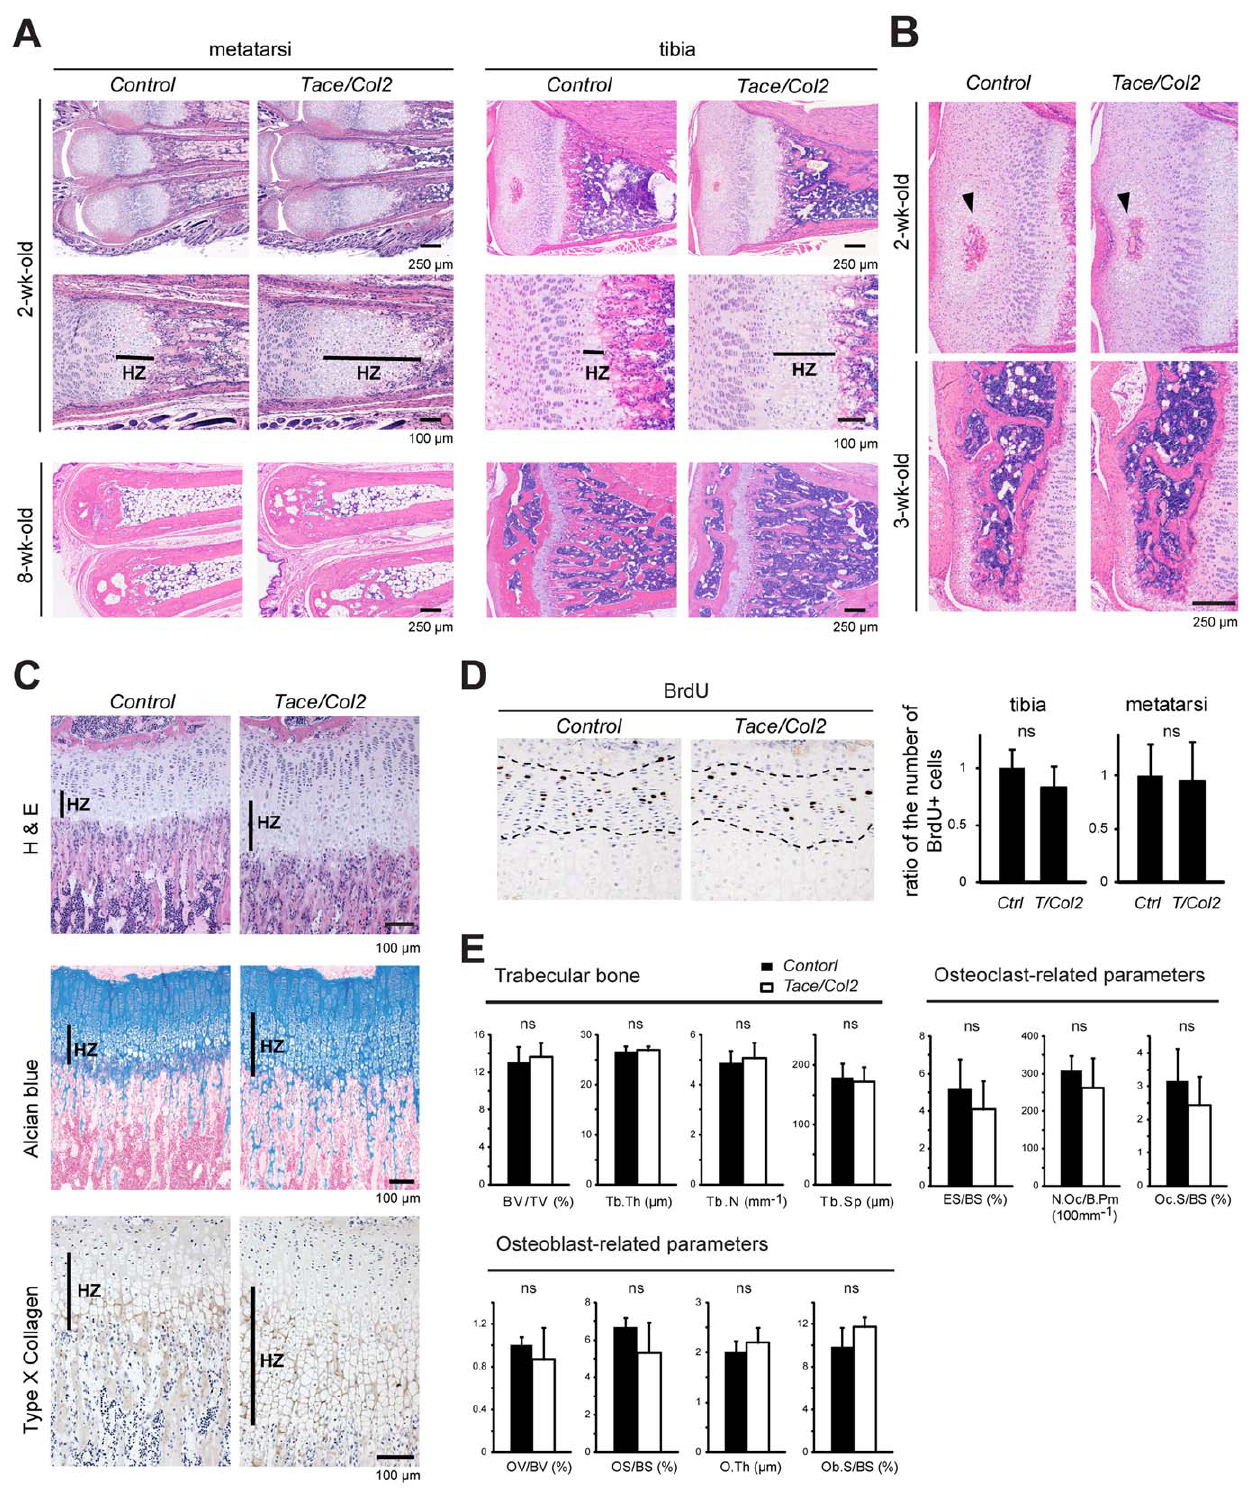
Figure 2. Histological and histomorphometric analysis of the long bones of Control and Tace/Col2 mice. (A) Histological analysis of the metatarsi and tibia (2-week-old, upper panels, and 8-week-old, lower panels, respectively) from Tace/Col2 and Control mice. HZ, hypertrophic zone. (B) Histological analysis of the secondary ossification center of the tibia (2-week-old, upper panels, and 3-week-old, lower panels, respectively) from Tace/ Col2 and Control mice. Arrowheads indicate the secondary ossification center. (C) Sections of tibiae from 3-week-old Tace/Col2 and Control mice stained with alcian blue (upper panels) or immunostained with anti-type X collagen antibody. (D) Immunolocalization of BrdU-incorporated chondrocytes in the proliferating zone (outlined by broken lines) of the tibia harvested from Control and Tace/Col2 mice (left panels). The ratio of the number of BrdU-positive chondrocytes in the proliferating zone of the tibia and metatarsus in Control and Tace/Col2 mice (right panels). The average